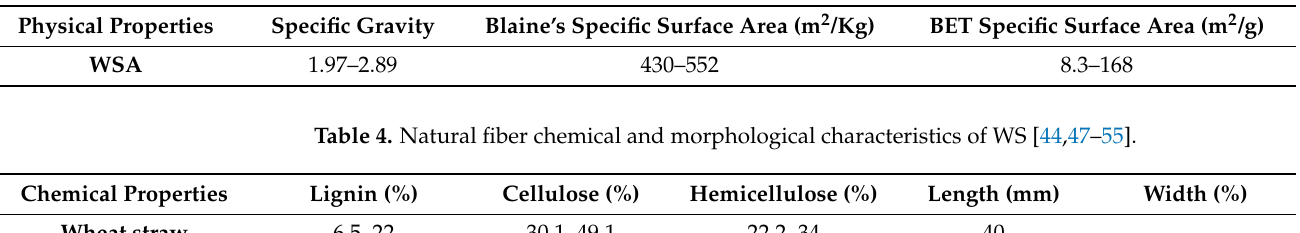
Table 3. Physical properties of WSA [17,18,39,41,42].